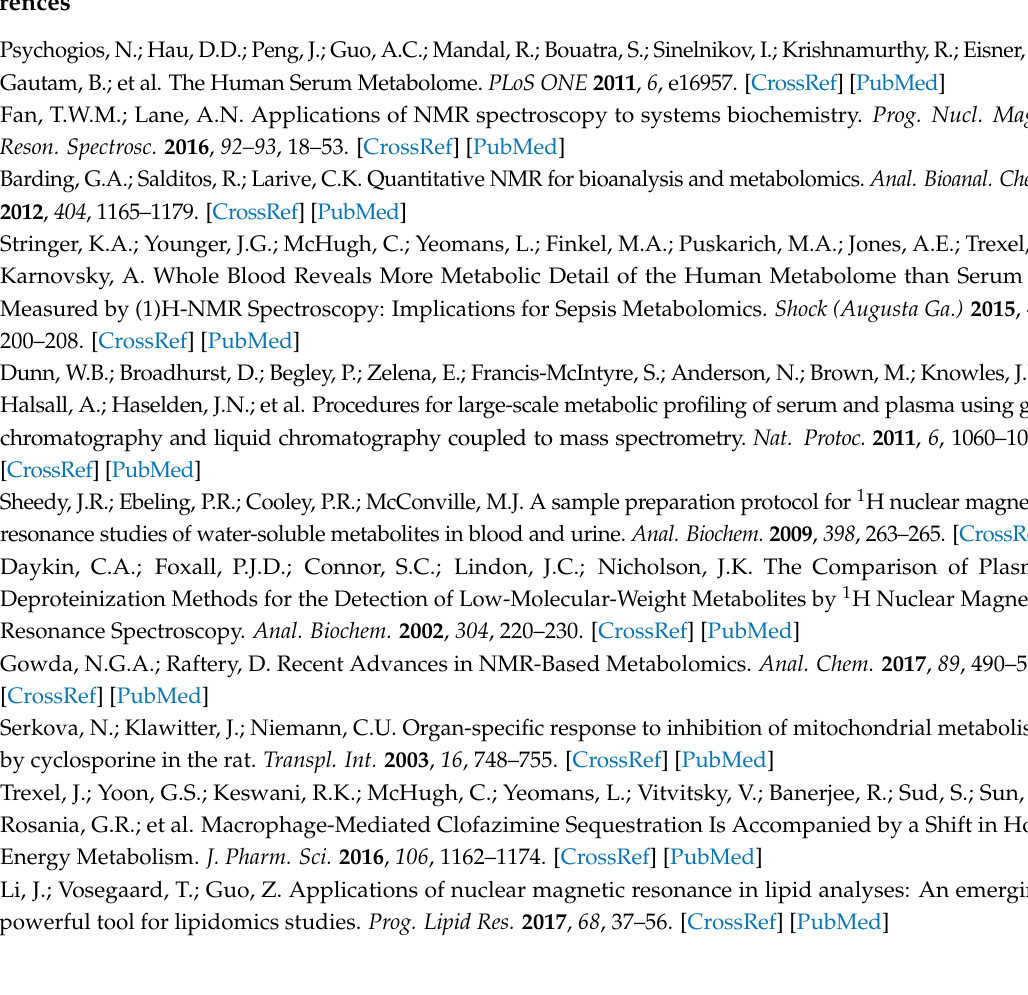
Table S1: Summary of data from pooled healthy human serum, Figure S1: Detailed annotated spectra of representative MeOH ppt + UF pooled healthy human serum, Figure S2: Representative spectra of ultrafiltered pooled healthy human serum, Figure S3: PCA plot of pooled healthy human serum, Table S2: Summary of concentration data from pooled human serum from sepsis patients, Figure S4: Representative 1 D - 1 H NMR spectra of pooled human serum from sepsis patients, Figure S5: PCA plot of pooled human serum from sepsis patients, Table S3: Summary of concentration data from matched healthy human serum extracted after short- or long-term storage, Table S4: Summary of concentration data from pooled healthy pig WB, Figure S6: Representative 1 D - 1 H NMR spectra of pooled healthy pig WB, Figure S7: PCA plot of pooled healthy pig WB, Table S5: Summary of concentration data from pooled healthy baboon WB, Figure S8: Representative 1 D - 1 H NMR spectra of pooled healthy baboon WB, Figure S9: PCA plot of pooled healthy baboon WB, Methods S4.4 Methanol:chloroform:water extractions–detailed